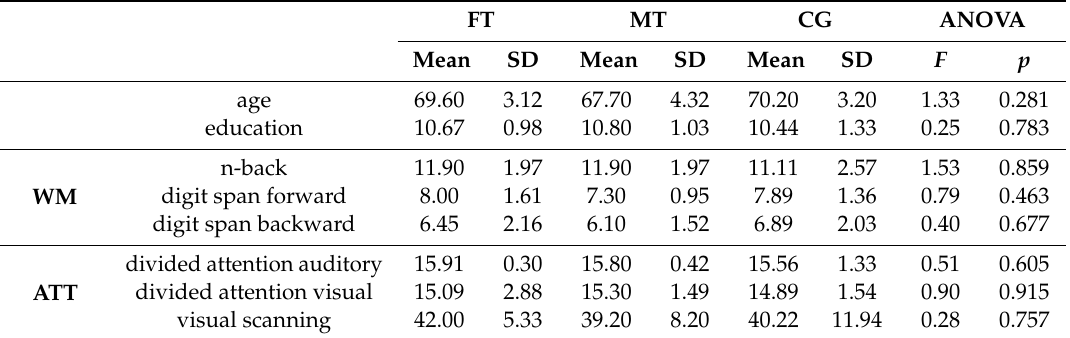
Table 1. Group comparisons for independent working memory and attention tasks.